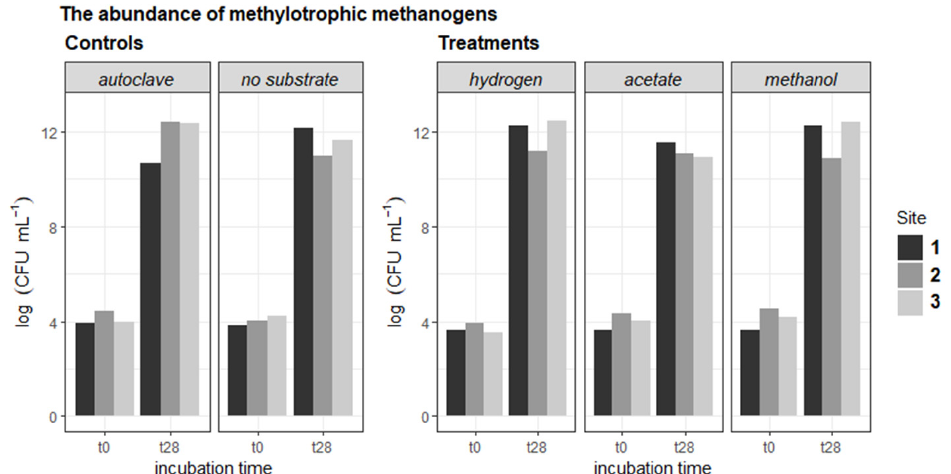
Figure 5. The abundance of methylotrophic methanogens in the sediment slurries on Days 0 and 28, counted on the selective agar media. Treatment indicated at the top of each panel. The values are the average of two replicates and five depths.